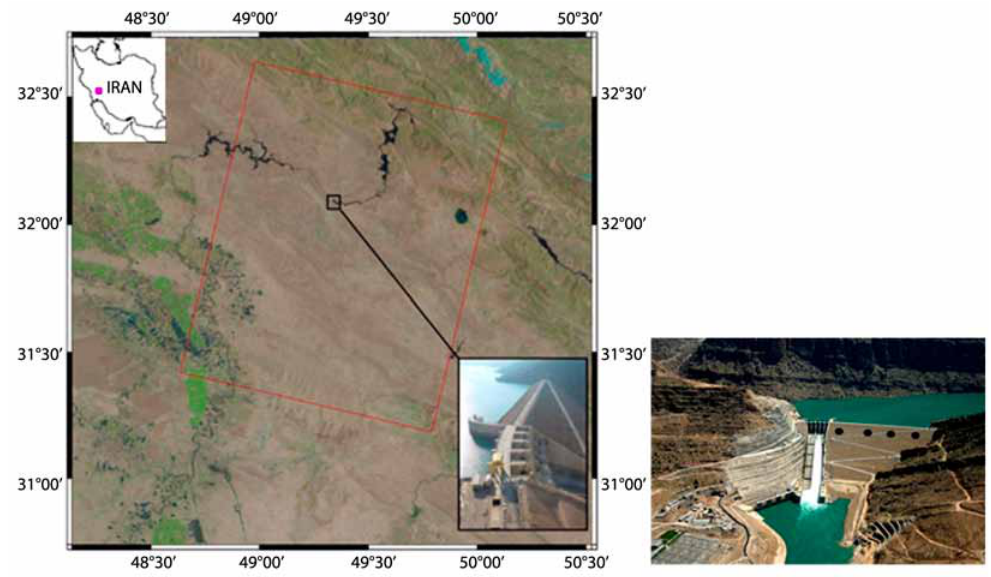
Fig. 1. Masjed Soleiman Dam, it’s Location, SAR image frame and geodetic points of Figure 2 (black